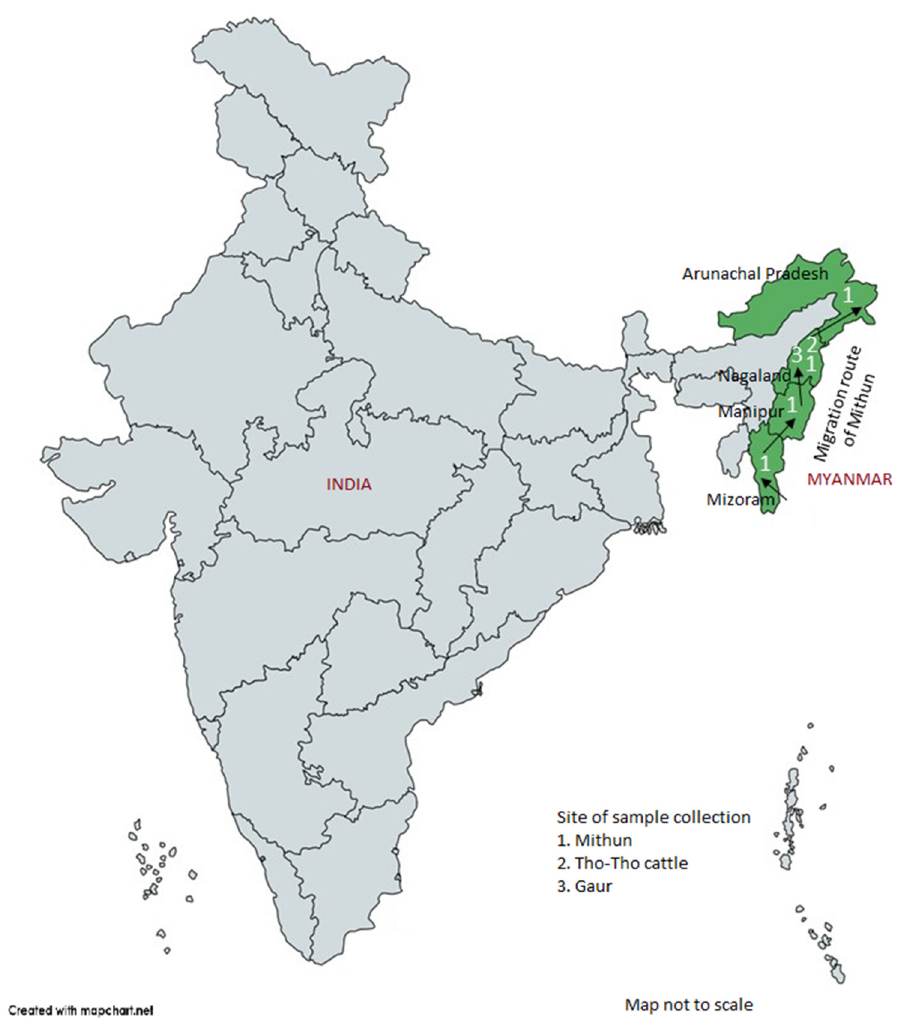
Figure 1. Indian map showing the approximate location of study populations (Mithun: 1, Tho-tho: 2, and Gaur: 3) and possible migration route of mithuns as per the direction of the arrows.